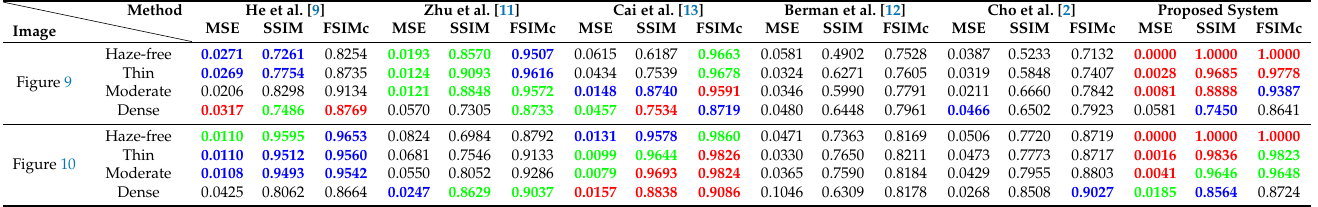
Table 7. Average MSE, SSIM, and FSIMc scores on synthetic aerial hazy images. Top three results for each image are boldfaced in red, green, and